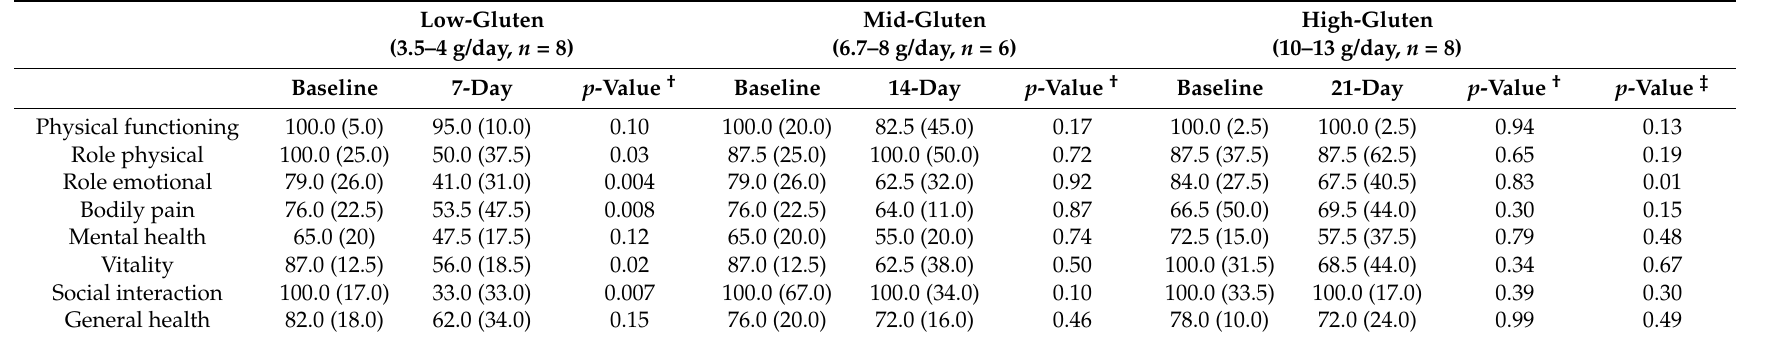
Table 4. SF-36 subscales and global score for quality of life 1 .